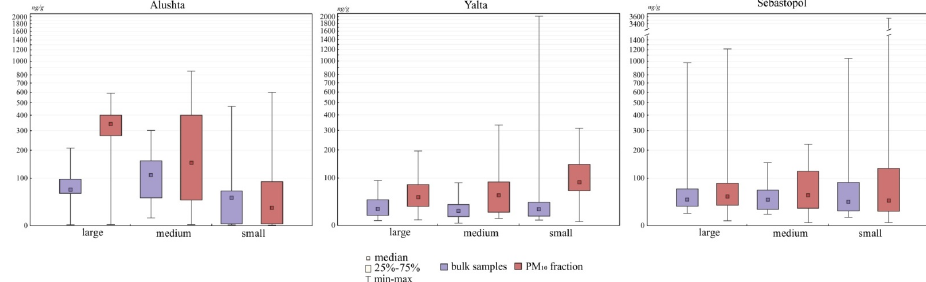
Figure 6. The content of benzo(a)pyrene in road dust and its PM 10 fraction for different types of roads in Alushta, Yalta and Sebastopol.